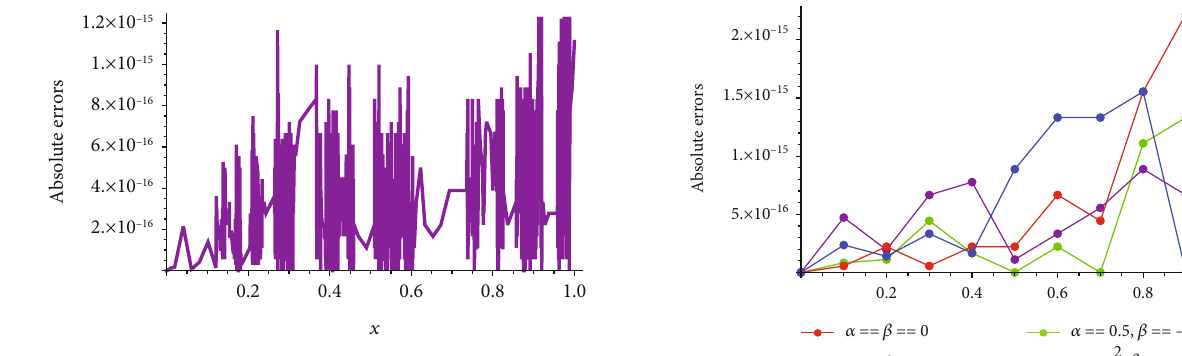
Figure 18: Absolute errors of u Example 3.